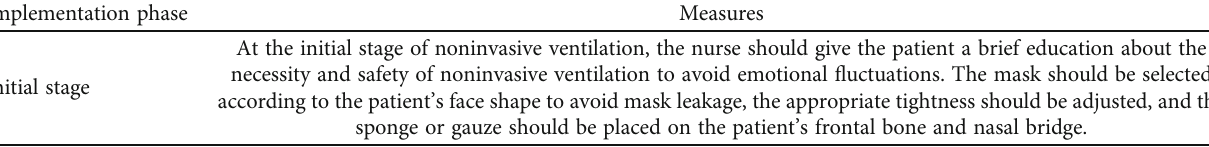
Table 1: Comparison of general information between the two groups [ (cid:1) x ± s